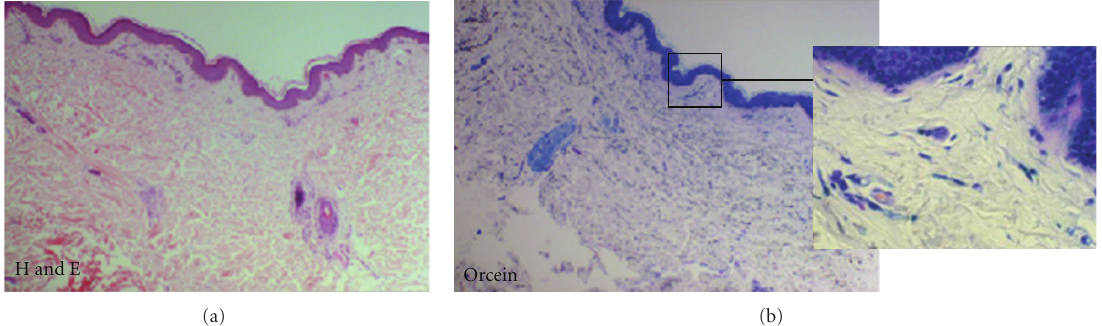
Figure 2: The histopathologic examination of a biopsy of one of the cutaneous lesions revealed: H&E stain: no alterations; Orcein stain: absence of elastic fibers in the papillary dermis.